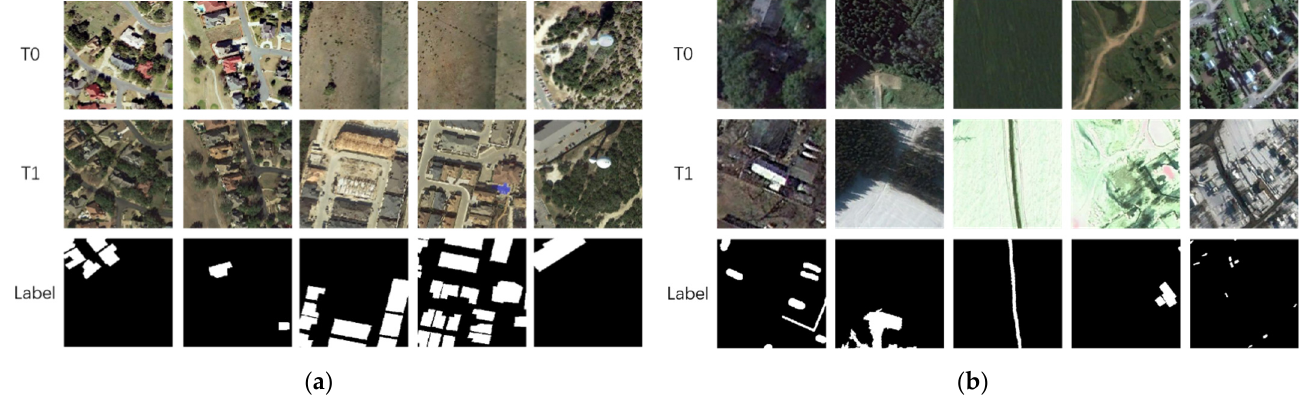
Figure 7. T0 is change before images, T1 is change after images, and Label represents the changed areas and the unchanged areas: ( a ) multitemporal remote sensing images from LEVIR-CD dataset; ( b ) multitemporal remote sensing images from CDD dataset.